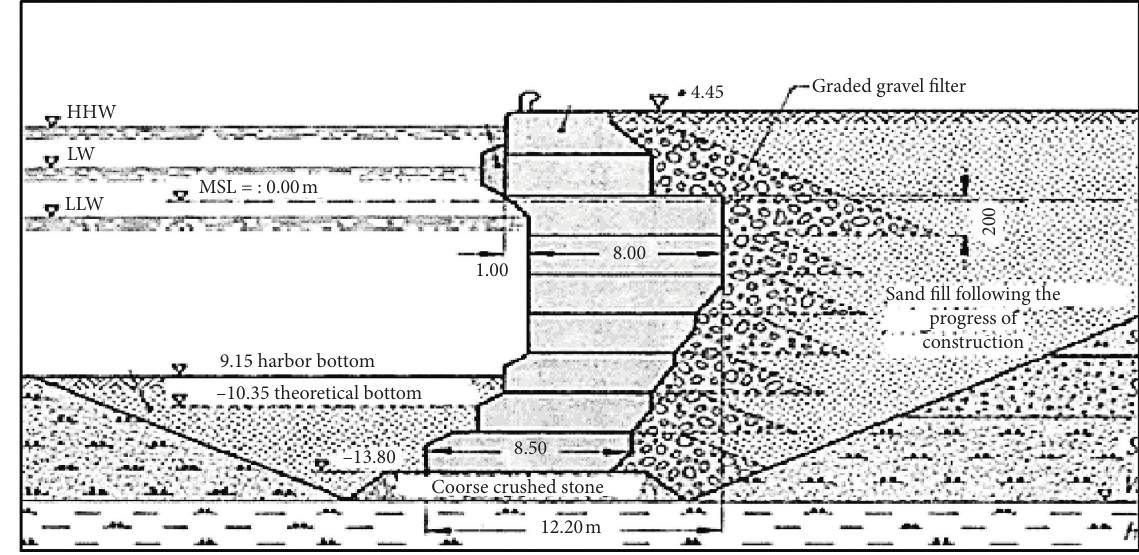
Figure 1: Granular materials used behind block piers